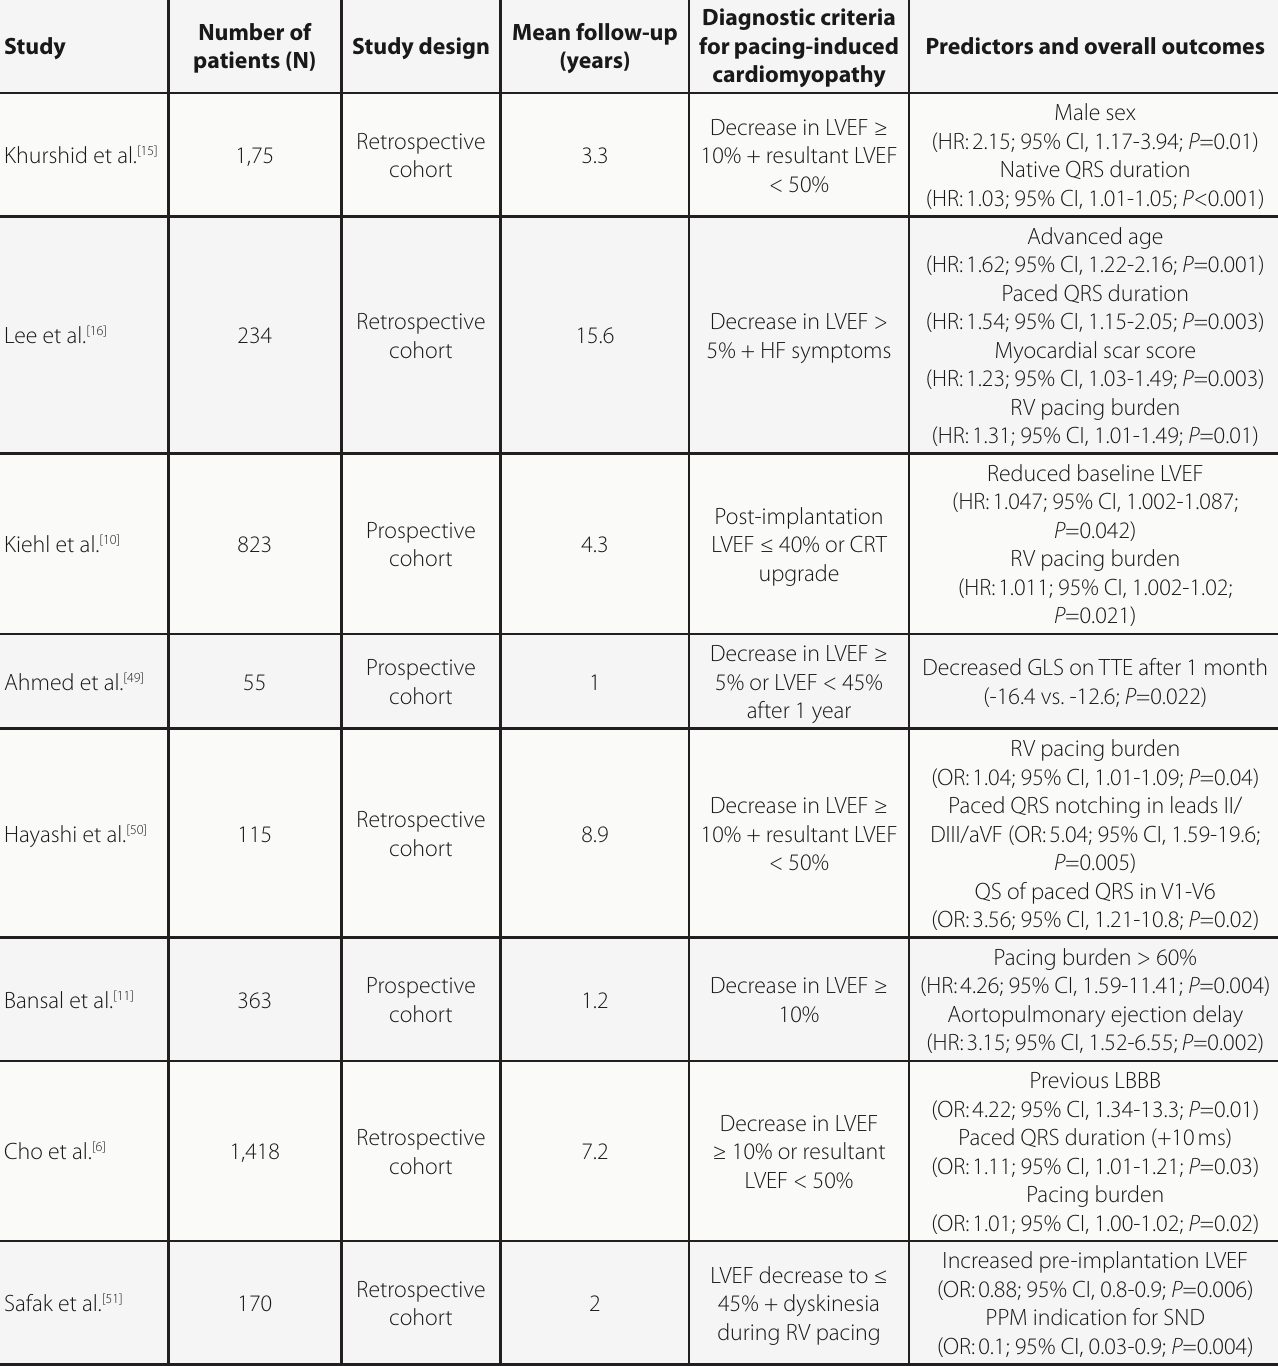
Predictors and overall